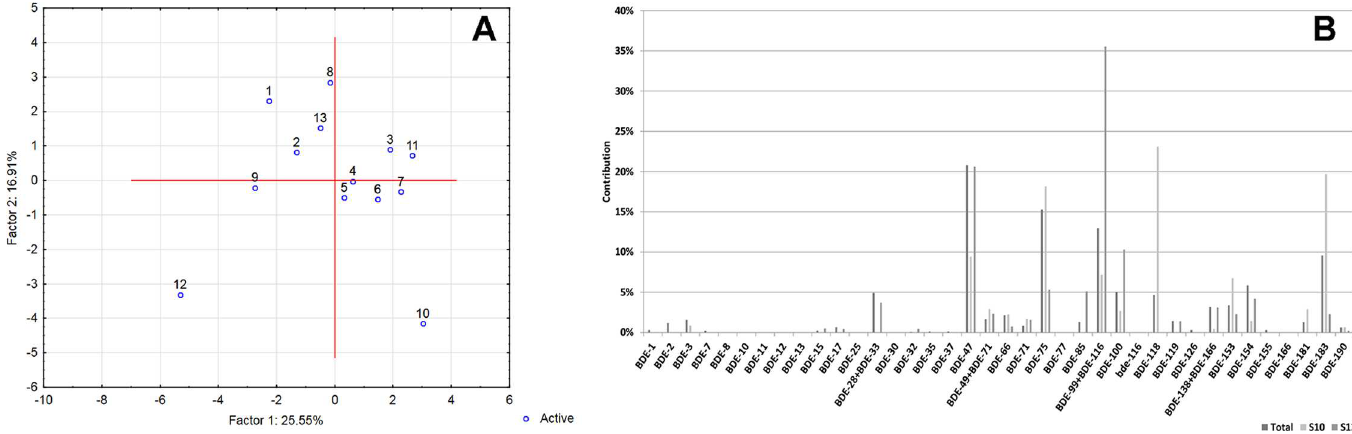
Fig 7. A- PCA scatter plot of PBDEs from 13 different samplingregions B–Averagecongener profile and the profiles observedfor the most diverse sampling points identifiedby